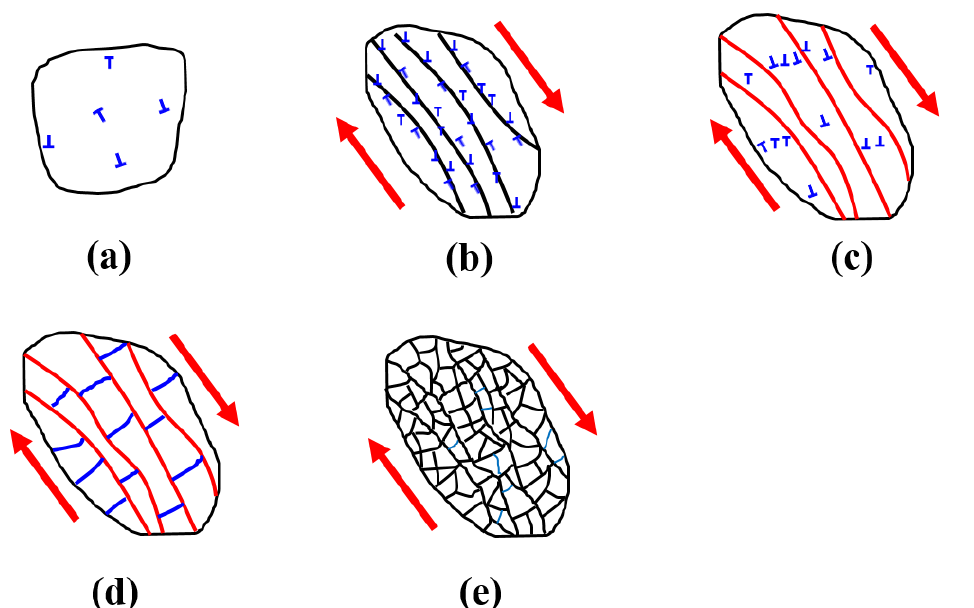
Figure 6. Detailed EBSD micrographs of elongated large grain inside the shear band (step size: 35 nm): ( a ) a typical IPF orientation map in the shear band superimposed by LAGBs and HAGBs; ( b ) KAM map superimposed by LAGBs and HAGBs; ( c ) the point-to-point and point-to-original miso- rientation profile along the path “L” and “T” drawn in an elongated grain in ( a ).